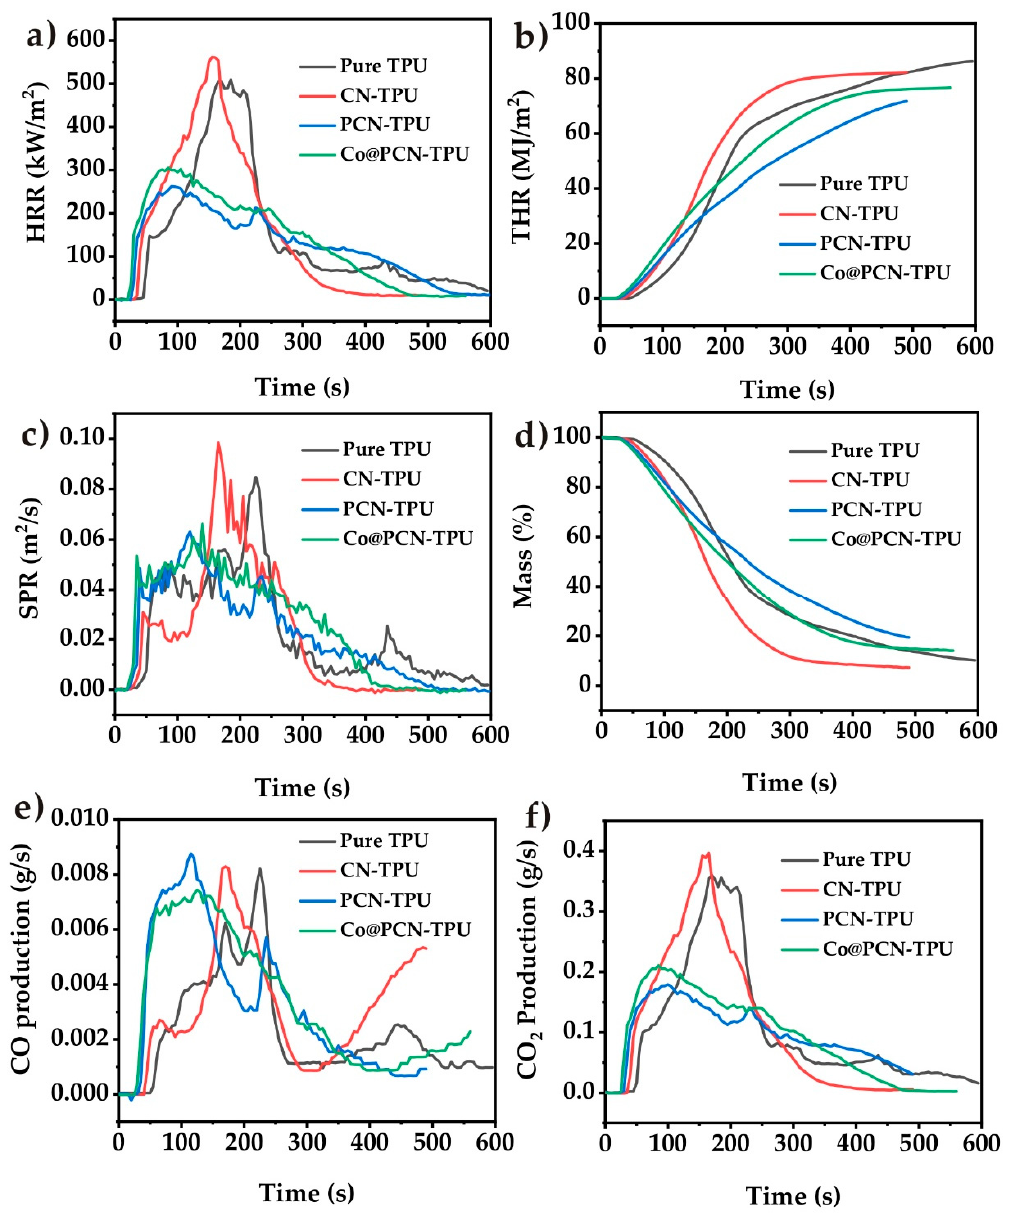
Figure 8. ( a ) Heat release rate (HRR), ( b ) total heat release (THR), ( c ) smoke-production rate (SPR), ( d ) mass, ( e ) CO, and ( f ) CO 2 curves of TPU and its nanocomposites obtained from cone calorimetry tests (CCTs).